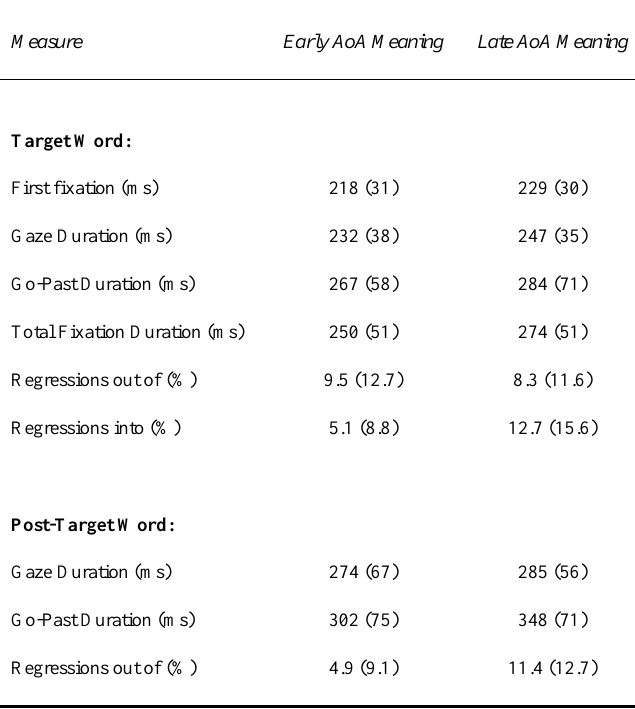
Participant means for Experiment